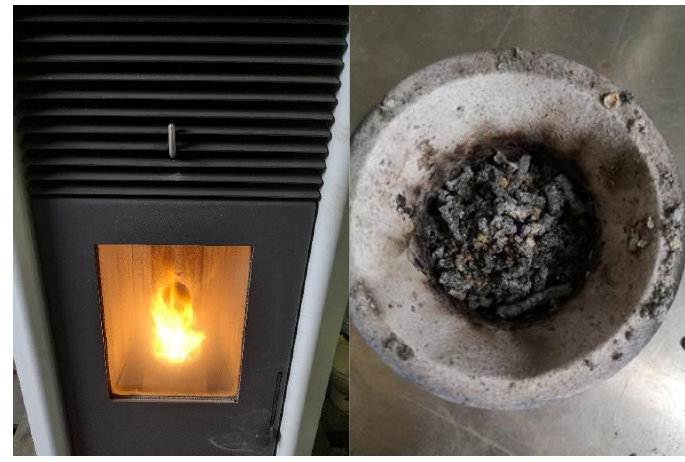
Figure 7. MIX3-1 pellets burning process.